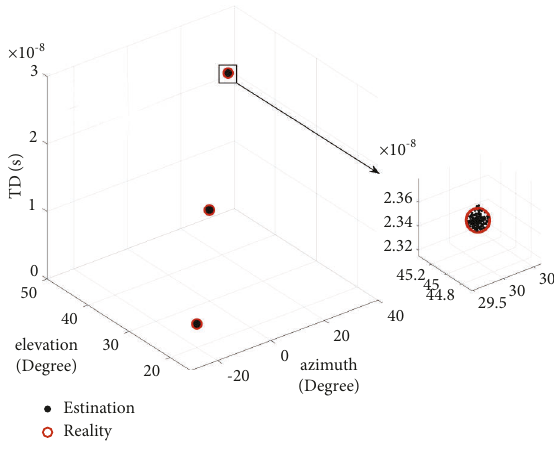
Figure 3: Estimated distribution at SNR � −